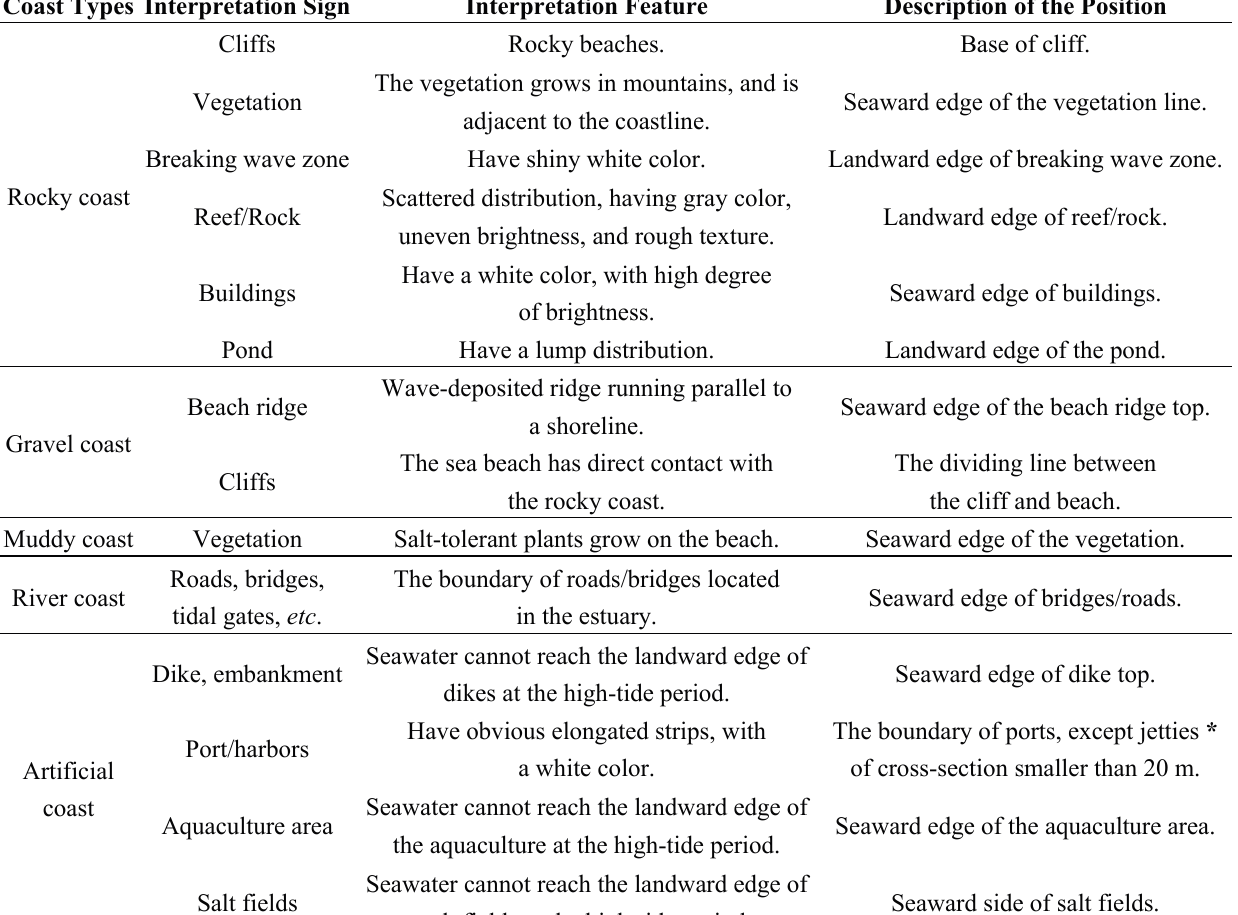
Table 3. Definitions of coastline position for different types of